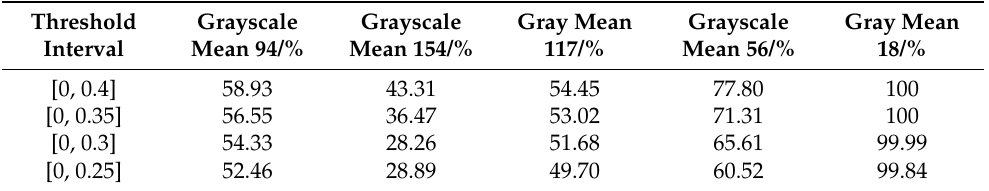
Table 4. Distribution probabilities of luminance values for different threshold boundaries of images with different